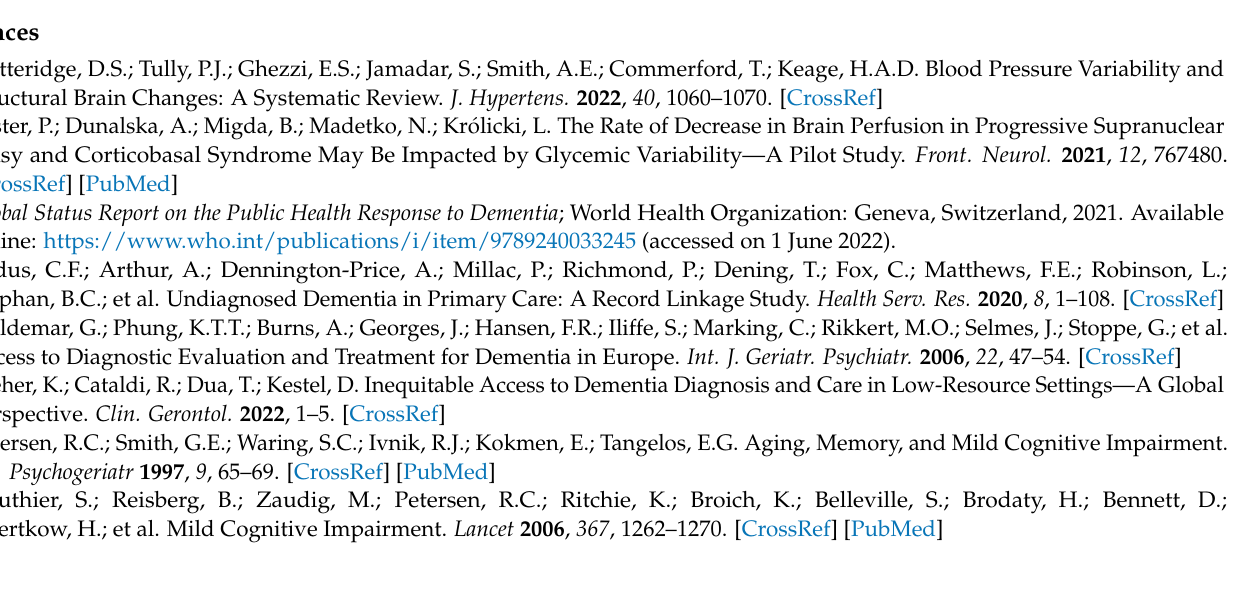
included studies. Table S2: Characteristics of computerized tests. Table S3: Diagnostic performance of digital cognitive biomarkers for mild cognitive impairments (MCI). Table S4: Diagnostic performance of digital cognitive biomarkers for dementia. Table S5: Diagnostic performance of digital cognitive biomarkers for cognitive impairments (CI). Table S6: Quality assessment based on The Newcastle– Ottawa Scale (NOS) [88–117]. Figure S1: Between-group mean difference in cognitive outcomes measured by computerized tests in mild cognitive impairments (MCI) and normal controls. Figure S2: Between-group mean difference in cognitive outcomes measured by computerized tests in dementia and normal controls. Figure S3: Between-group mean difference in cognitive outcomes measured by computerized tests in cognitive impairments (CI) and normal